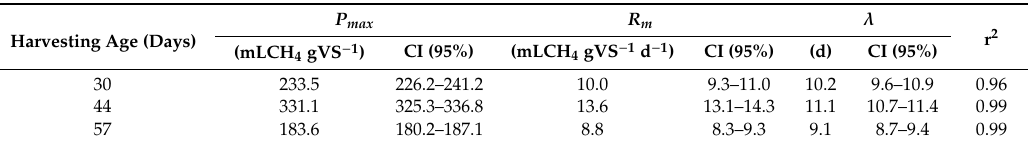
Figure 1. Specific methane yield over time for harvesting ages ( n = 3). Table 2. Parameters of the Gompertz equation adjustment on harvesting age biochemical methane potential (BMP) tests ( Pm , Rm , and λ ), confidence interval (CI with α = 0.05) and evaluation of the coefficient of determination (r 2 ).